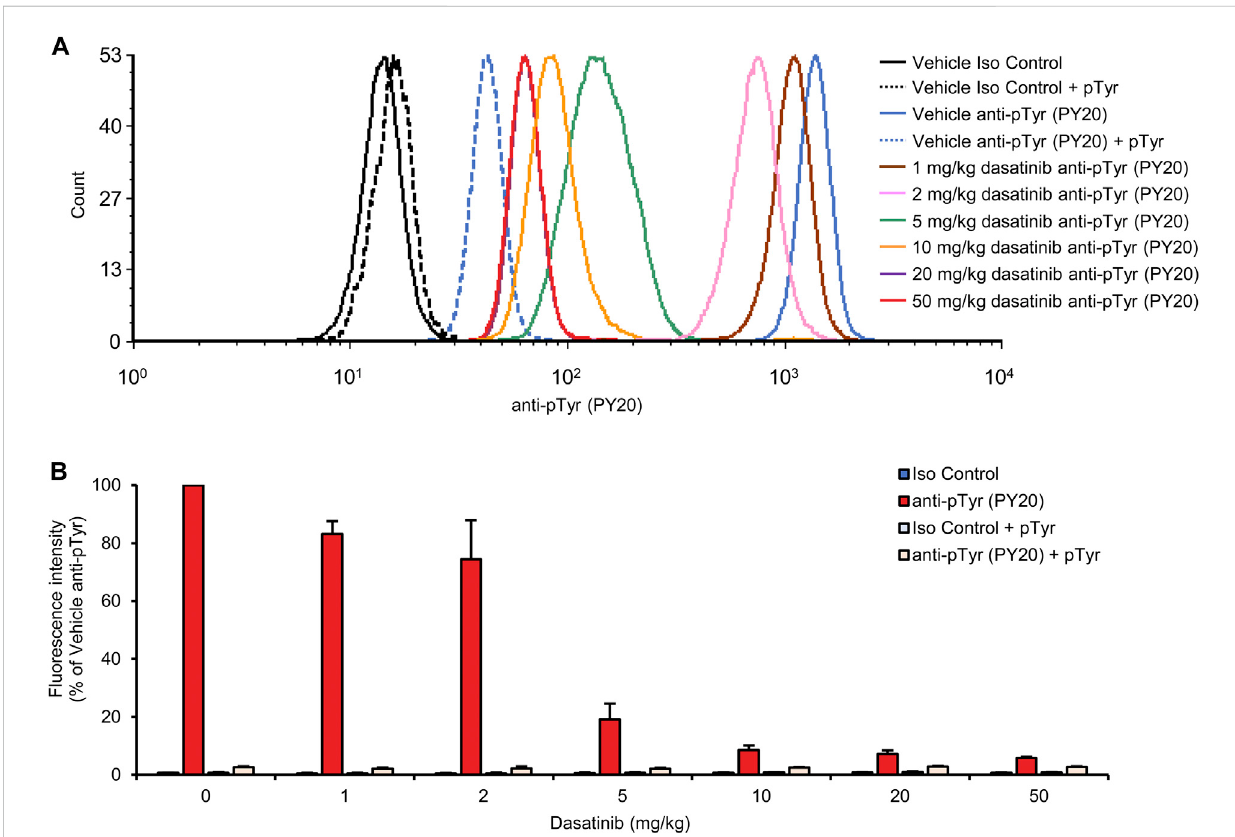
FIGURE 6 Dose-response relationship of dasatinib treatment. Wild-type mice were treated with vehicle or 1, 2, 5, 10, 20 or 50 mg/kg dasatinib by oral gavage. Blood samples were obtained 2 h later and stained with the PY20 anti-phosphotyrosine antibodies or isotype controls. Where indicated, the anti- phosphotyrosine antibodies were presaturated with 4 mM soluble phosphotyrosine. Representative fl ow cytometric histograms (A) or geometric mean fl uorescence intensity values normalized to those of vehicle-treated samples stained with anti-phosphotyrosine antibodies without any presaturation with their antigens (B) are shown. The bar graph shows mean and SEM from 3-8 mice per treatment from at least three independent experiments. pTyr, phosphotyrosine; Iso,